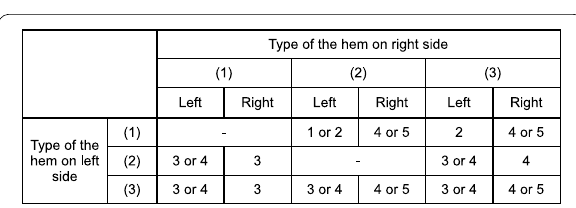
Fig. 8 The relationship between the type and position of the hem when two edges are visible on the near side